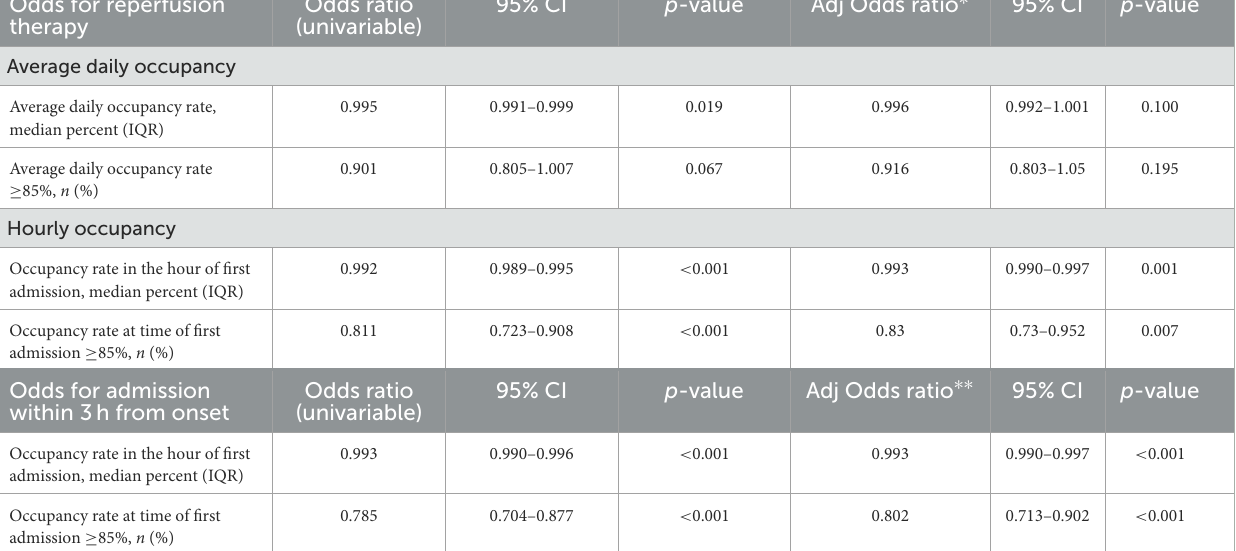
TABLE 2 Association between bed occupancy and odds for reperfusion therapy and admission within 3h from the symptom onset. Odds for reperfusion therapy